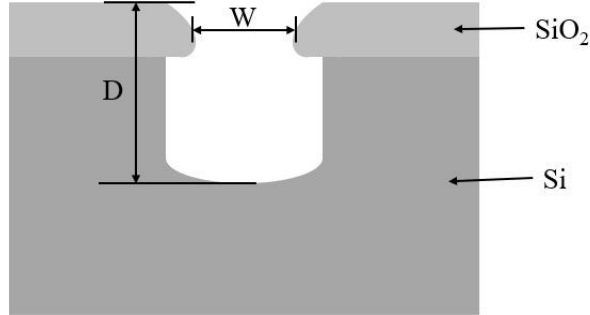
Figure 2. MEMS trench section diagram and its geometric parameters. W, width; D,